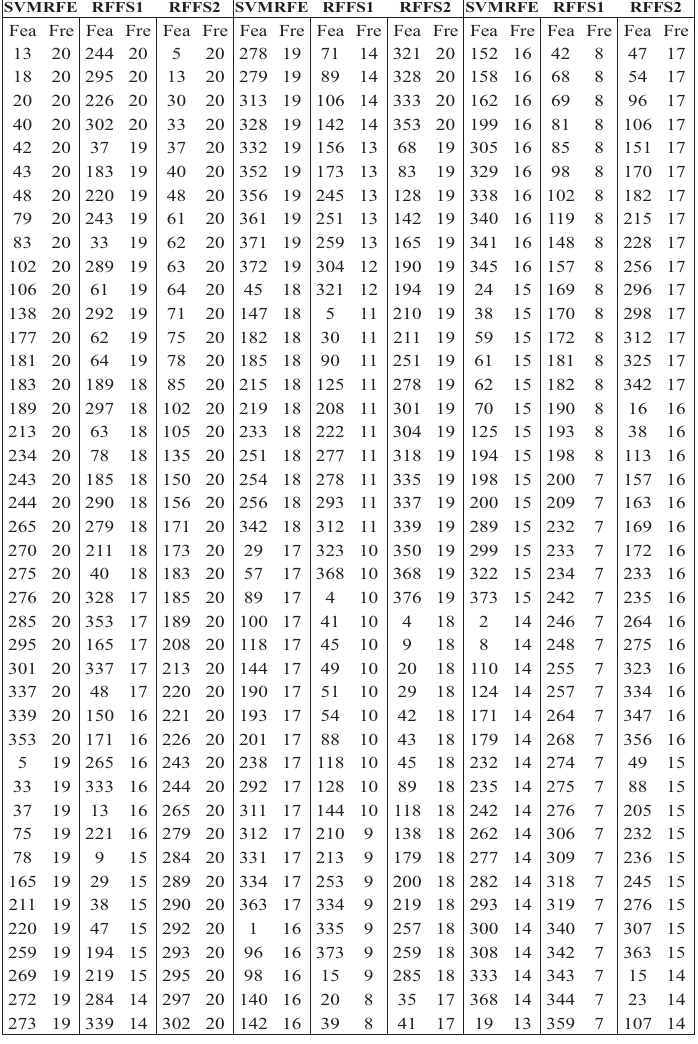
Figure A5. SVMRFE and RFFS results of FNC data, Part